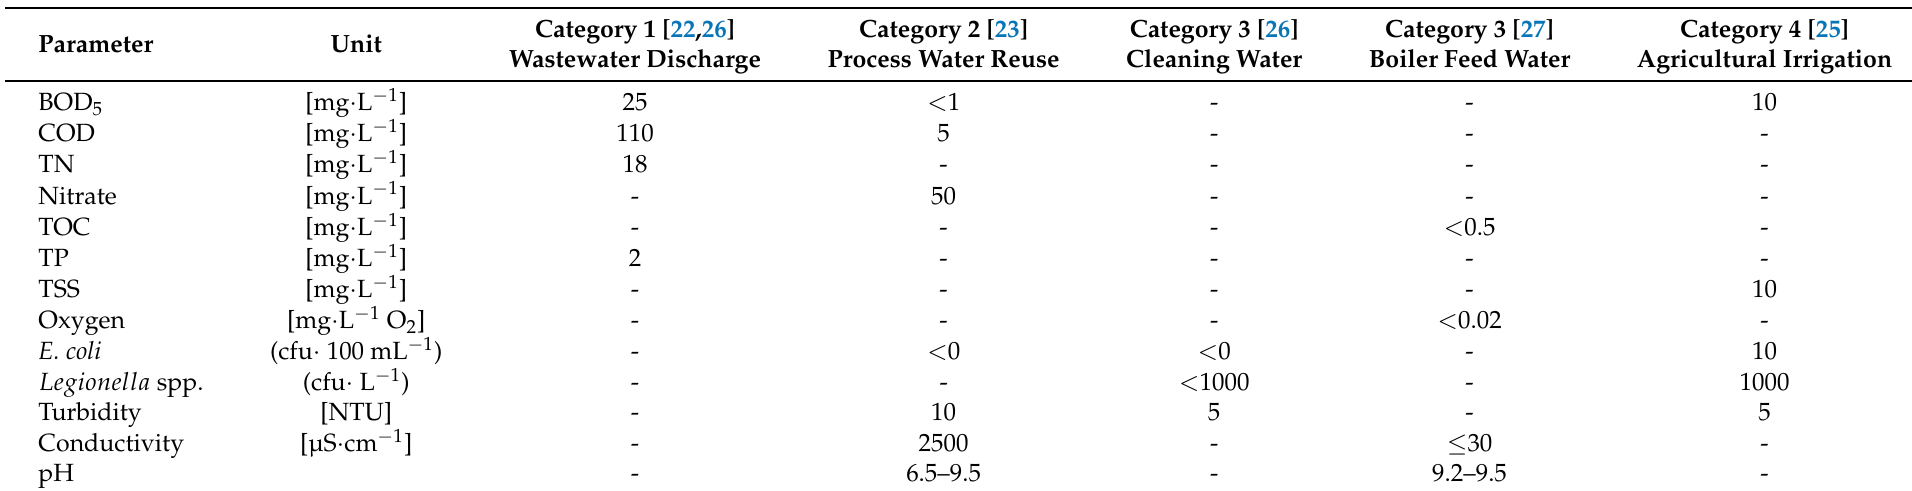
Table 3. Limits for wastewater